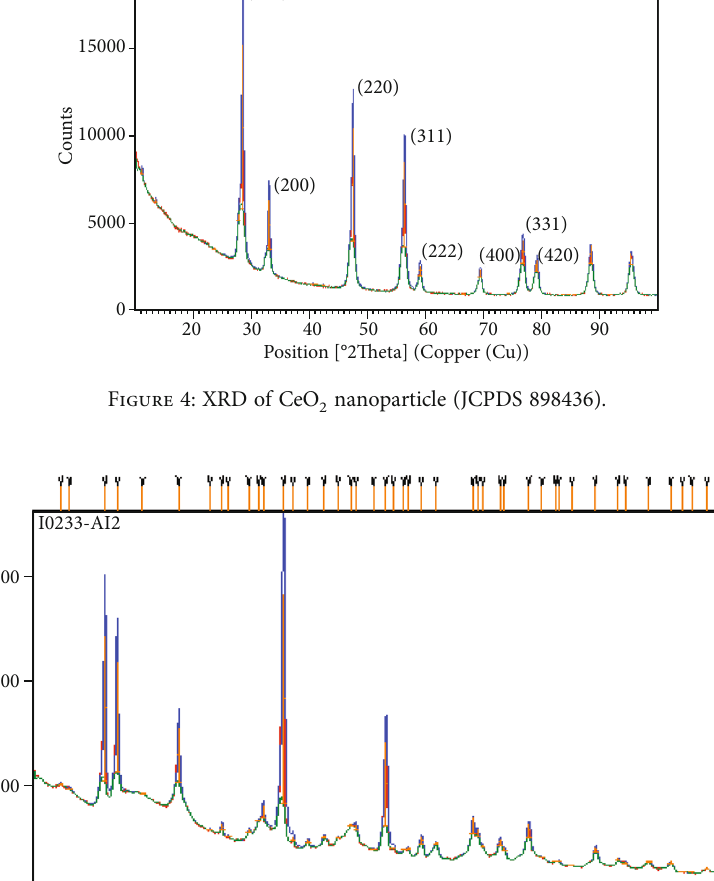
SiO nanoparticle. 2 5